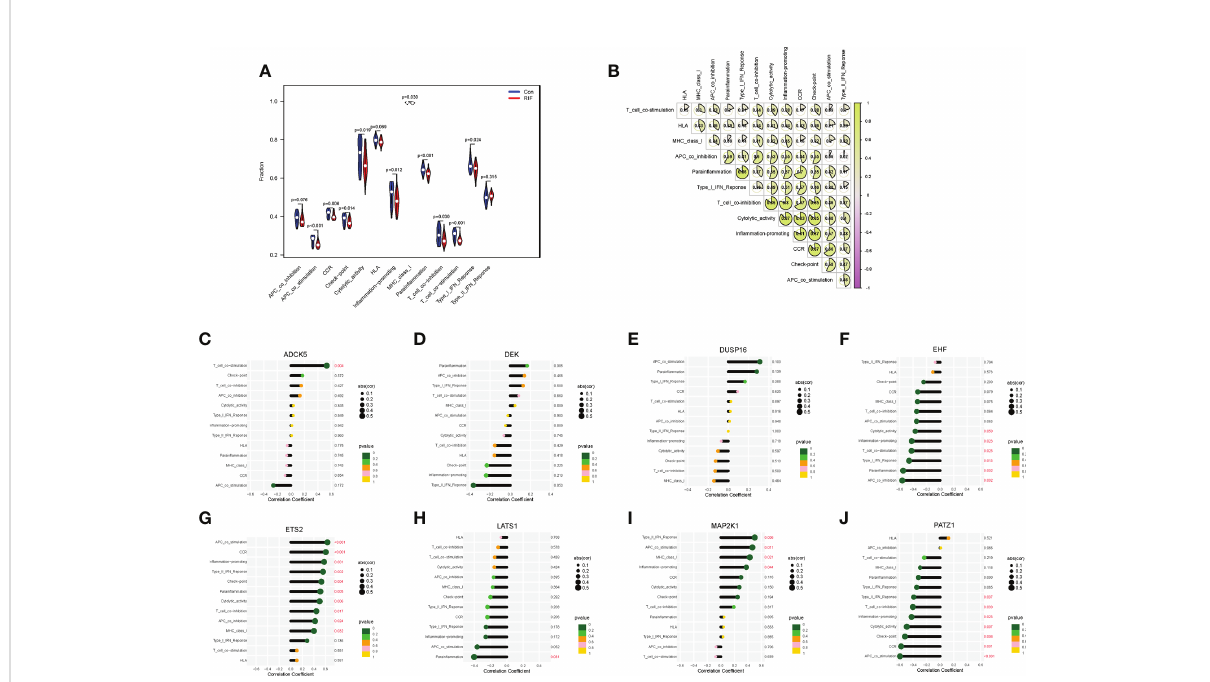
FIGURE 6 Immune function landscape of RIF and its correlation with RIF signature genes. (A) The distribution of immune functions between RIF and control samples. (B) Correlation heatmap showed the correlation between different immune functions in RIF samples. (C – J) The lollipop chart showed the correlation between RIF signature genes and immune functions in RIF samples.